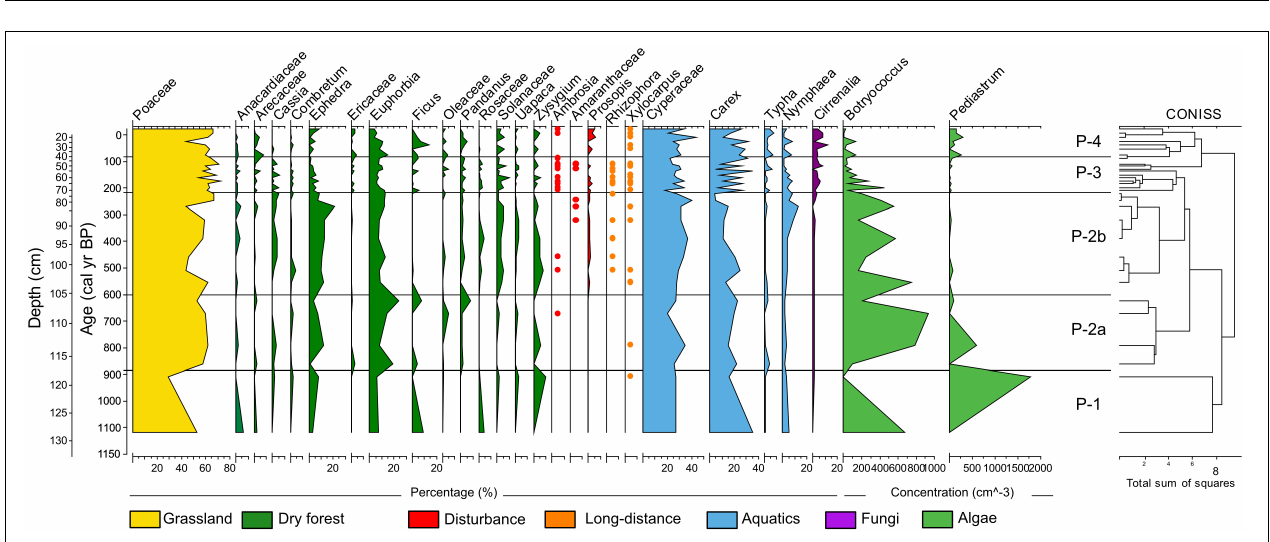
FIGURE 3 | Depth versus XRF-PC1 and XRF-derived element abundances normalized to Zr, from the Namonte sediment core, southwest Madagascar. Mean values are indicated by vertical lines and pollen and diatom zones are marked by different colors.